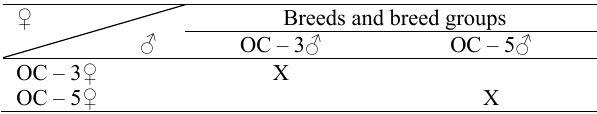
Scheme of the research, (n = 50)